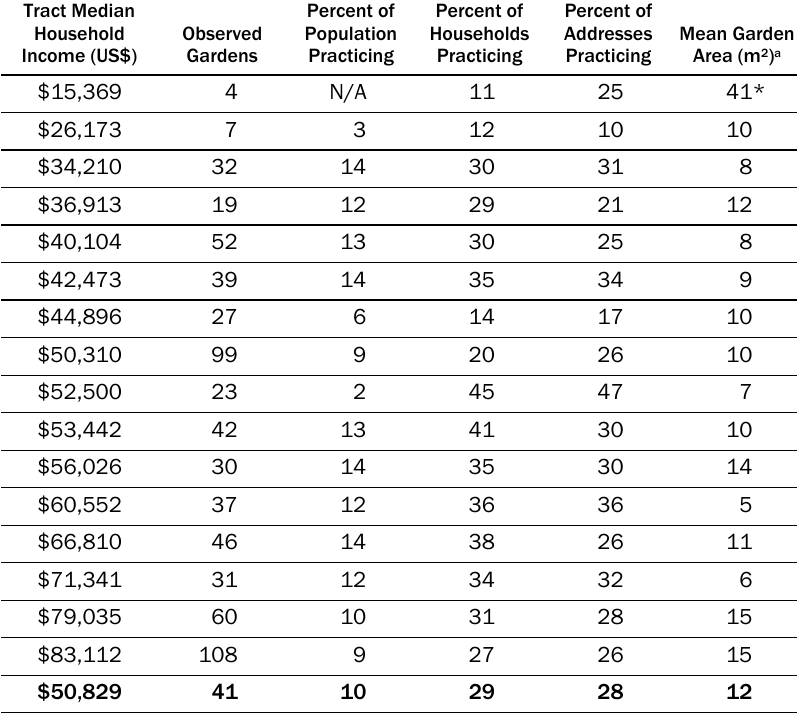
Table 1. Home Garden Frequency and Mean Garden Size of Census Tracts by Ascending 1999 Median Household Income as Reported in the U.S. Census Means are identified in bold for all census tracts sampled. Likelihood of participation in home gardening appears to decrease as median household income